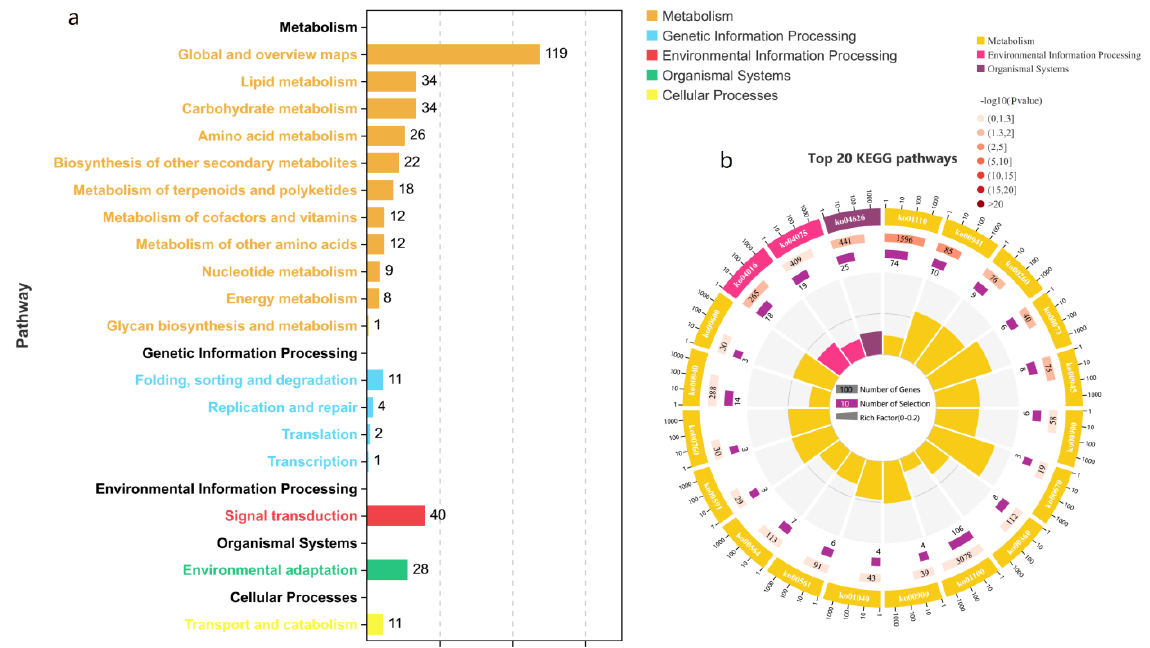
Figure 7. KEGG pathway enrichment of 943 genes differentially expressed specifically during the Ont7813 response process. ( a ) Statistics of the DEGs in different pathways. ( b ) Enrichment of the top 20 KEGG pathways.